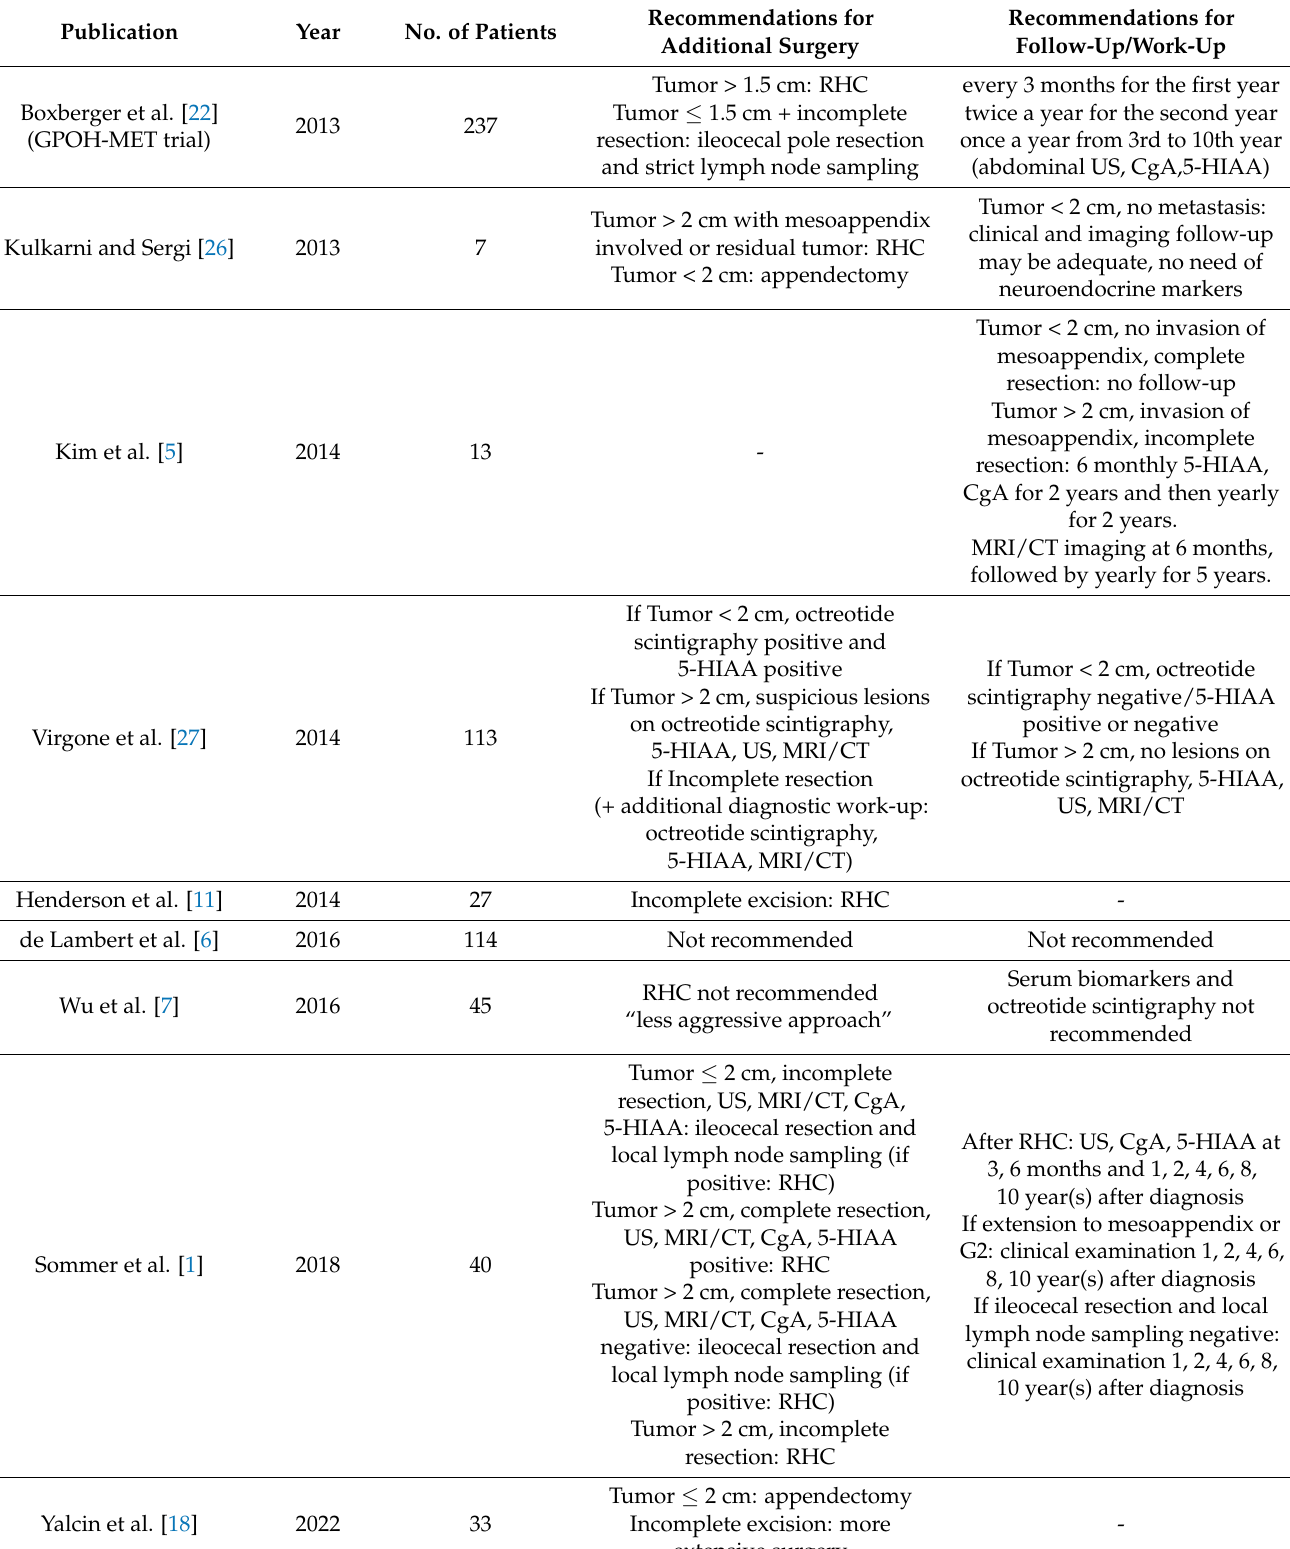
Table 2. Recommendations for additional surgery and work-up/follow-up modalities in children and adolescents from latest publications (sorted by year of publication, adapted from